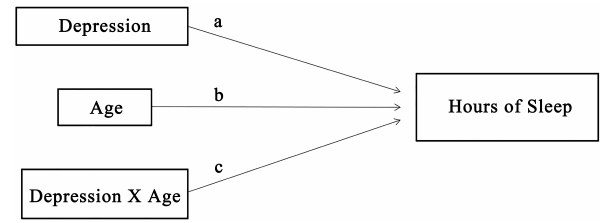
Fig. 1. Moderation